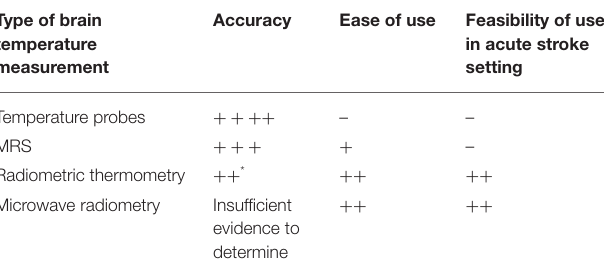
TABLE 2 | Brain temperature measurement and acute stroke